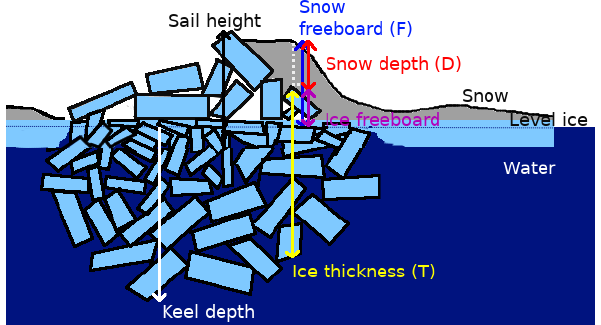
Figure 1. A schematic diagram of a typical first-year ridge. The ridge may not be symmetric, and peaks of the sail and keel may not coincide. The effective density of the ice is affected by the air gaps above water and the water gaps below water. T , D and F may be linked by assuming hydrostatic balance (Eq. 1).